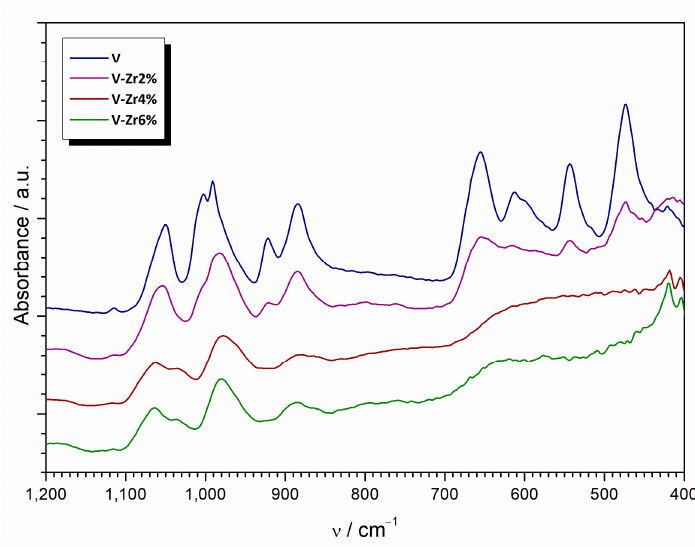
Figure 7. FTIR spectra of pure V to V-Zr6% precursors samples.